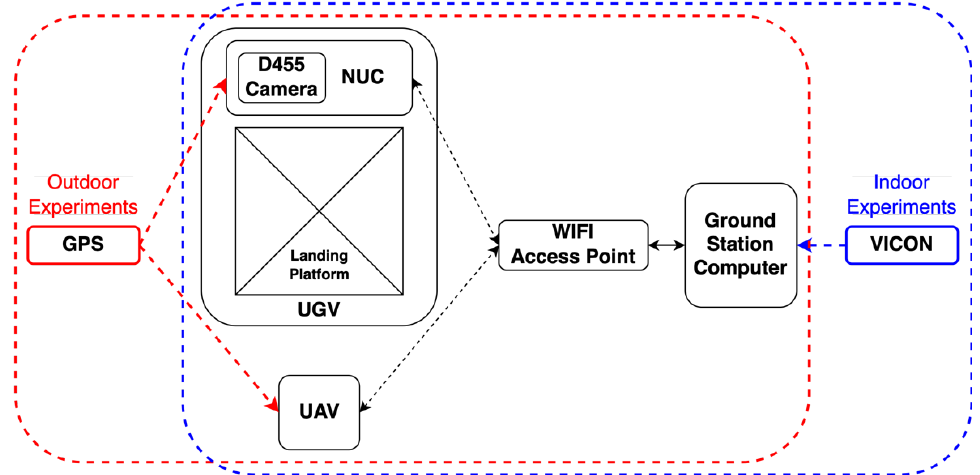
Figure 8. The framework of the experimental setup.